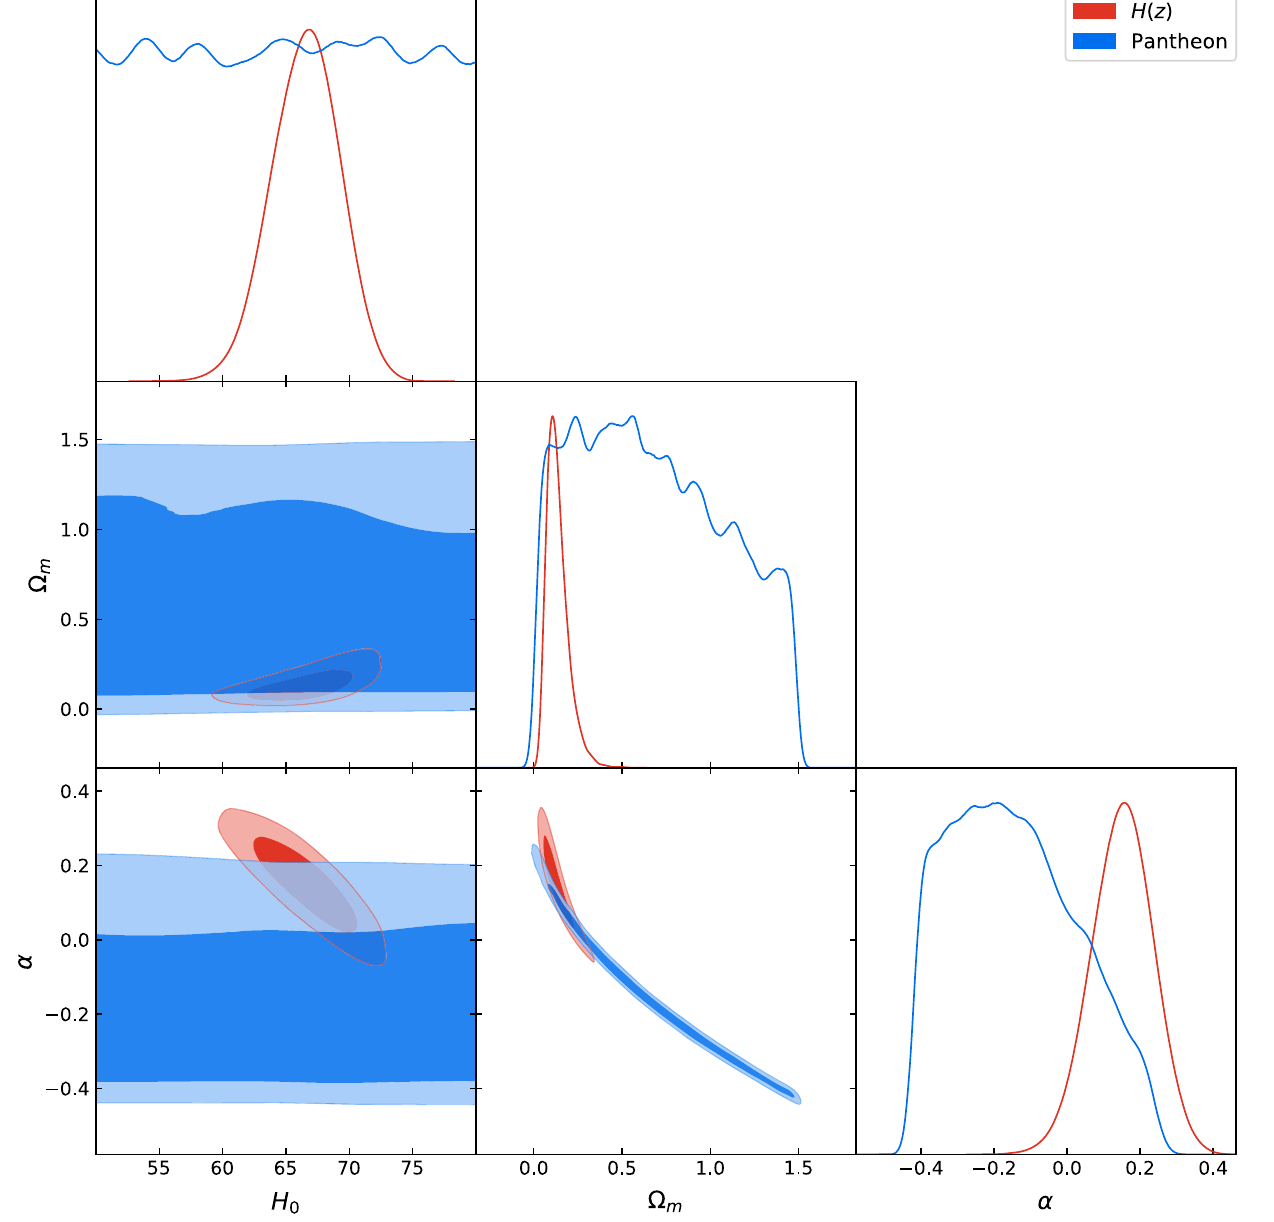
Fig. 1 Separate analysis using SNe Ia – Pantheon (blue) and 51 H ( z ) data (red), for the constraints of the main parameters, H 0 , (cid:7) m and α , for Case